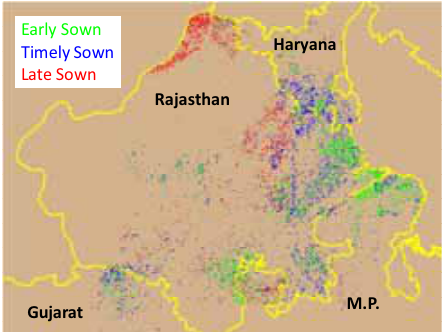
Fig. 6: Spatial Crop Sowing Pattern of Mustard Crop: Study States, India